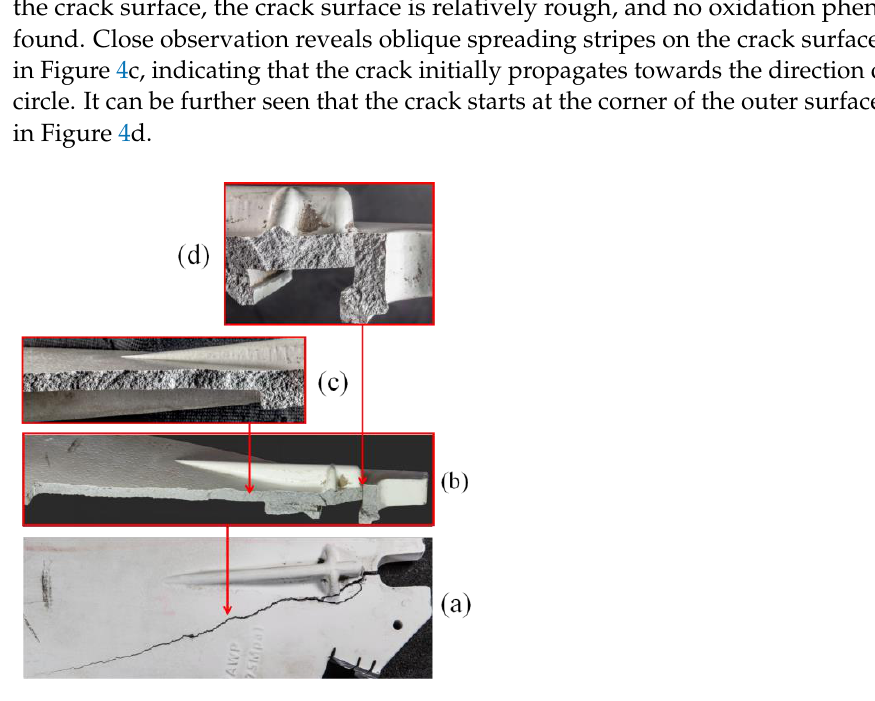
Figure 4. Macro morphology of crack and crack surface at six o’clock: ( a ) whole crack, ( b ) crack after opening, and ( c , d ) two parts of the crack